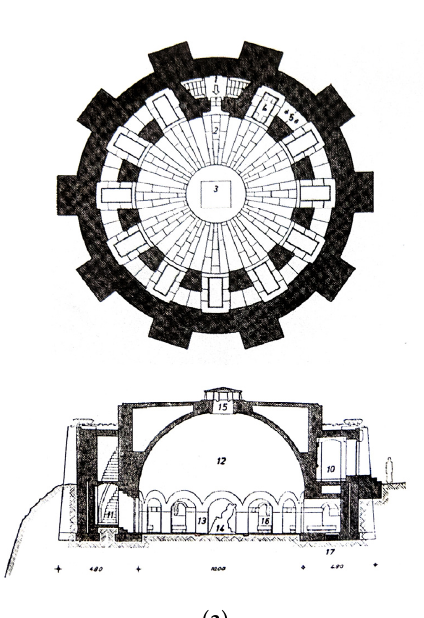
Figure 1. Saint Anne Mountain: ( a ) German Thingstätte, model; ( b ) Monument mausoleum of the fallen German soldiers from the Volunteers Corps (Freikorps), view from the open-air theatre ( Schlesische Monatshefte 1938, May 15: 12, 13).